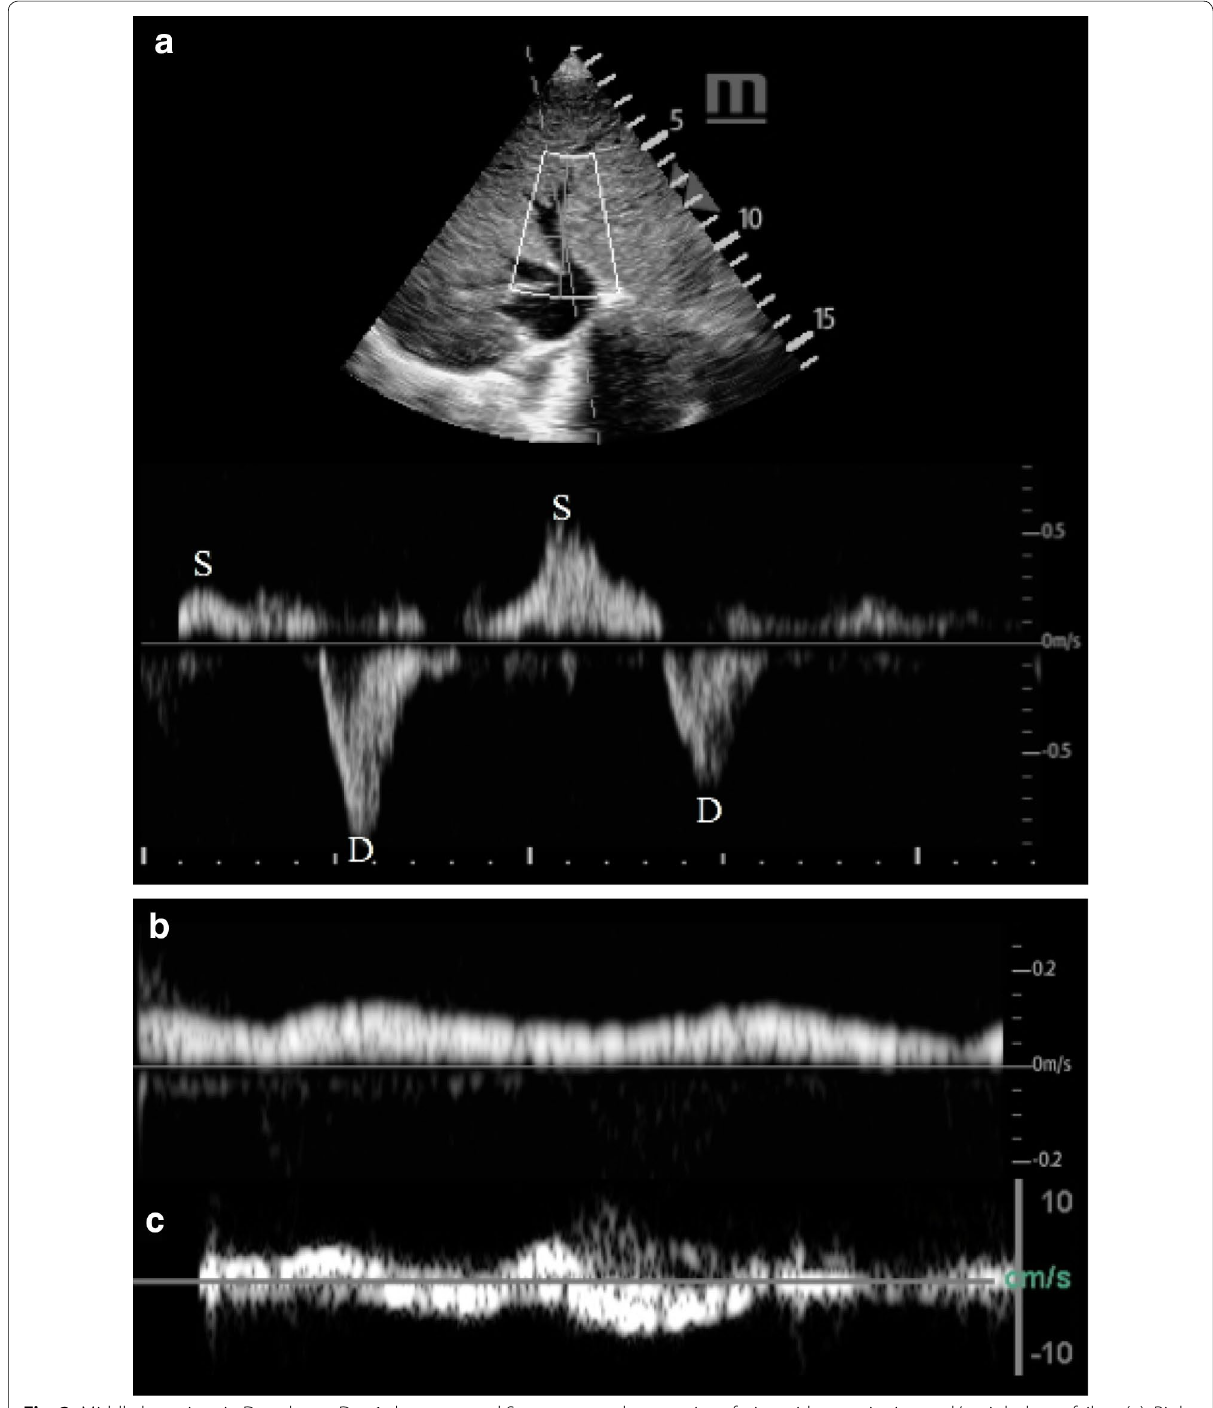
Fig. 3 Middle hepatic vein Doppler on Day 1 demonstrated S wave reversal suggestive of tricuspid regurgitation and/or right heart failure ( a ). Right portal vein Doppler on Day 1 demonstrating reduced portal venous flow suggestive of venous congestion ( b ). Right portal vein Doppler on Day 5 demonstrating portal venous flow reversal suggestive of severe heart failure and venous